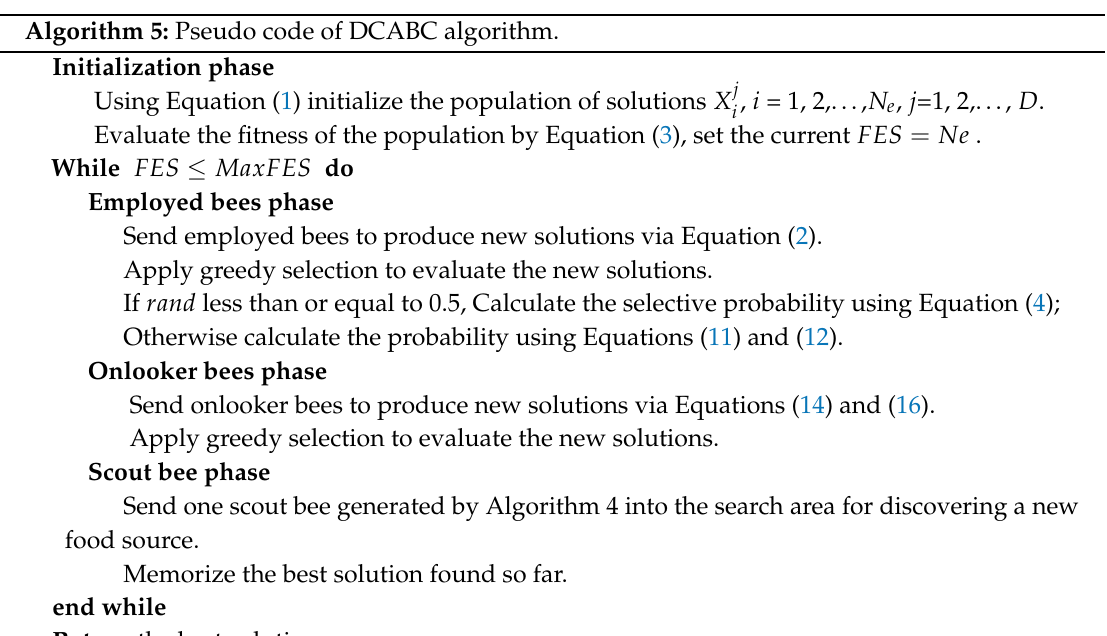
Algorithm 5: Pseudo code of DCABC